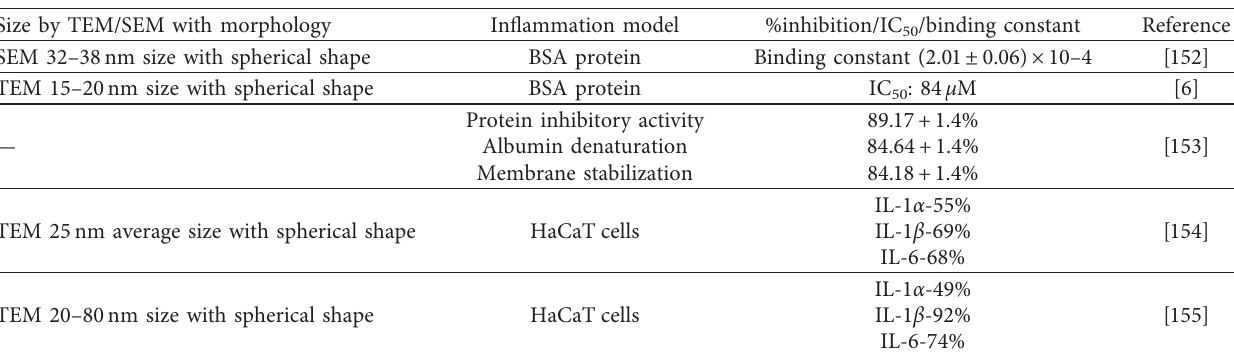
Table 4: Morphology of green synthesized Ag NPs and their anti-inflammatory activity on different inflammation models.